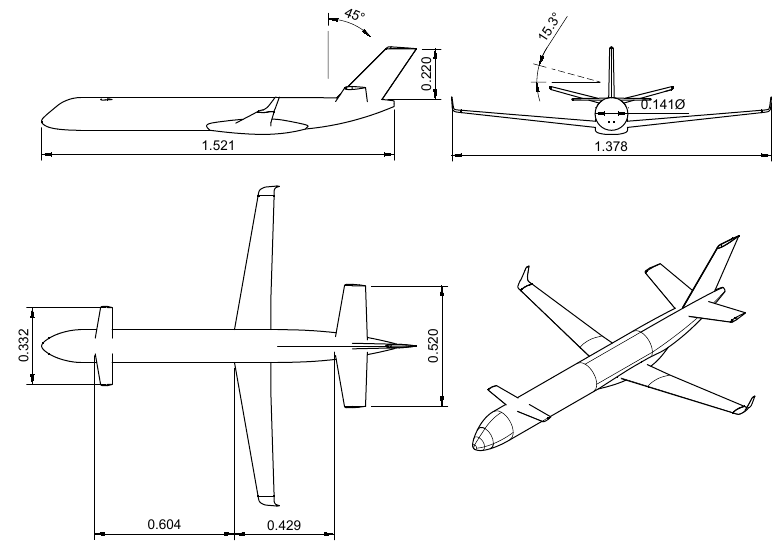
Figure 1. Scaled aircraft model at the end of design loop 1. Units in